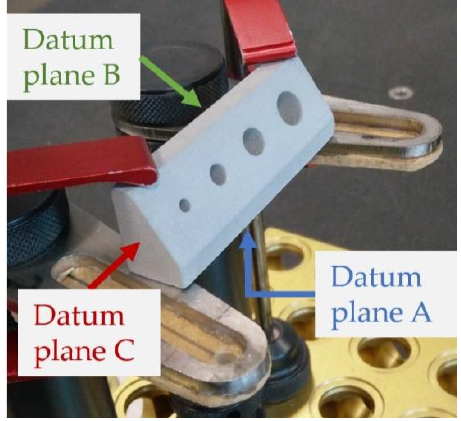
Figure 4. Example of the clamping system and the datum planes used for the alignment procedure.